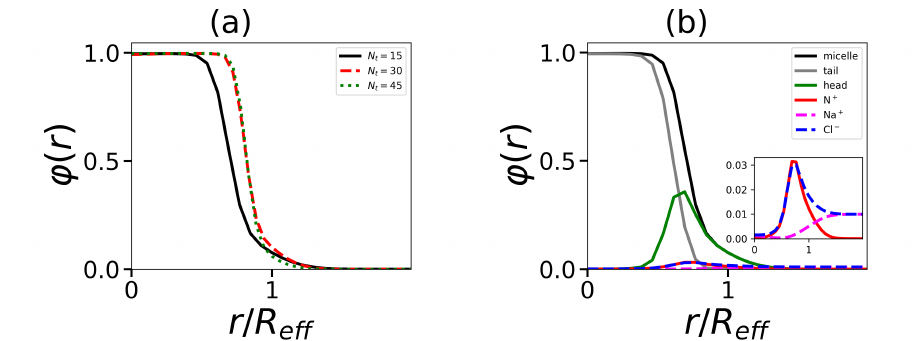
Figure 5. The normalized density profiles (by effective radius R ef f , which are defined below) ( a ) for segments in micelle with tail length N t = 15, 30, 45 and ( b ) the distribution of tail (grey), head groups (green), and overall (black) for hydrid molecule with tail length N t = 15. The distributions of the charged group in the dendron (red), co-ions, and counterions (pink and blue) are also given in the inset in an enlarged scale. All cases correspond to the same number of tails t = 4 and generation number G =